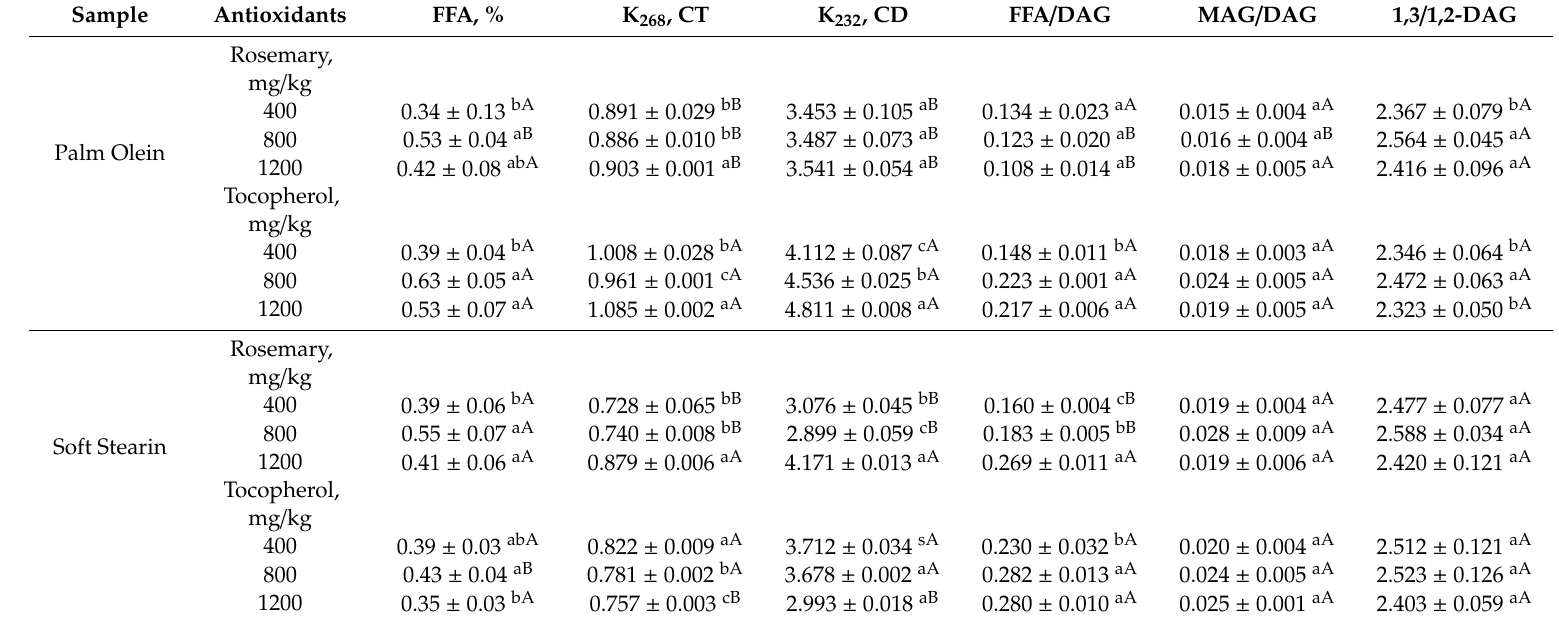
Values are the mean of three determinations from two replicate experiments ± standard deviation ( n = 6). Mean values with di ff erent superscript letters in the same column are significantly di ff erent at p < 0.05 by ANOVA and the Tukey test. Mean AB values of the same column for each parameter are significantly di ff erent at p < 0.05 (comparison between rosemary and tocopherol addition in each